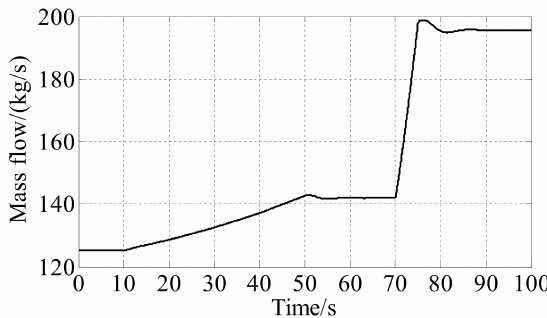
Figure 25. Mass flow change of outlet air